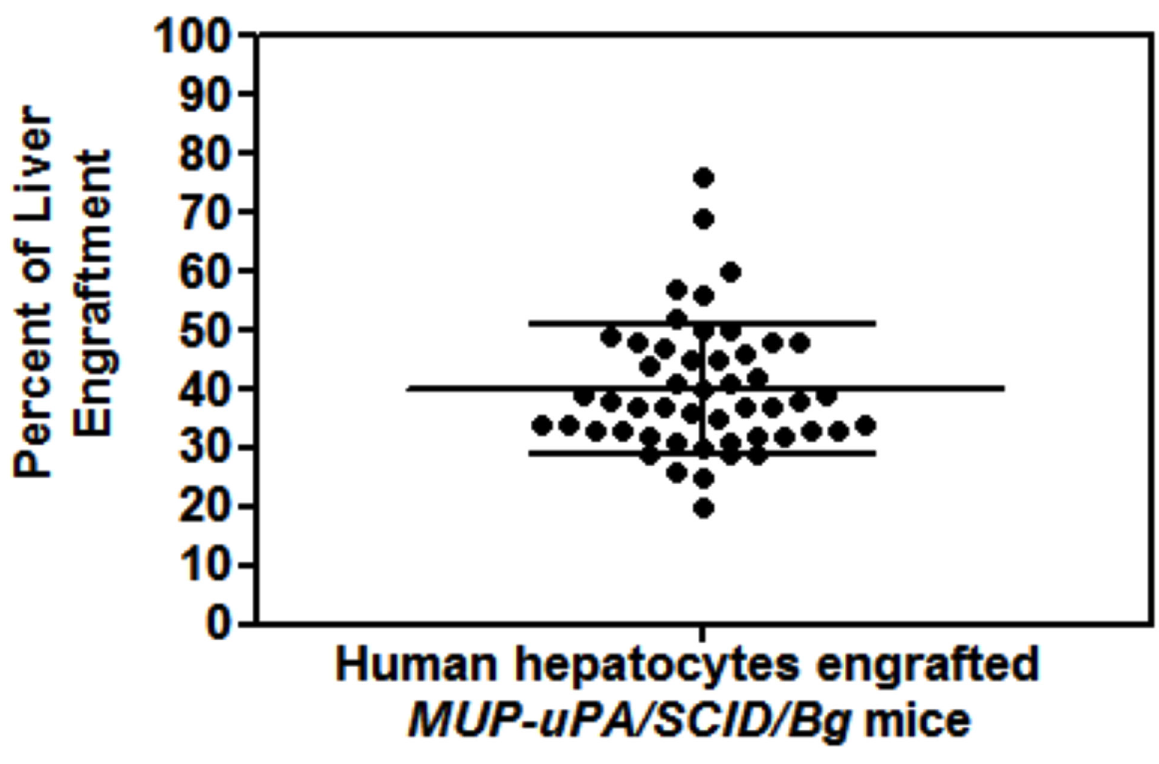
Figure 5. The level of human hepatocyte repopulation of transgenic mouse livers as determined by immuno-staining liver sections from human hepatocyte engrafted transgenic mice. Plot represents the mean and interquartile ranges of human albumin levels (ug/mL) in the serum of MUP-uPA-SCID/Bg mice transplanted with different numbers of human hepatocytes. (n=50; ***P < 0.0008).